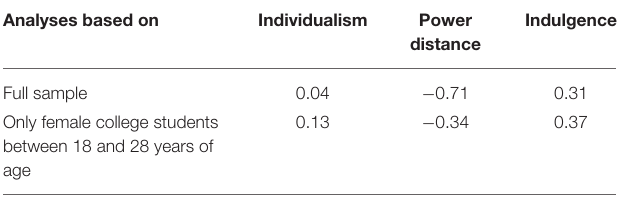
TABLE 2 | Cronbach’s alpha, based on standardized items (at country level), for three scales from VSM 2013. Analyses based on Individualism Power